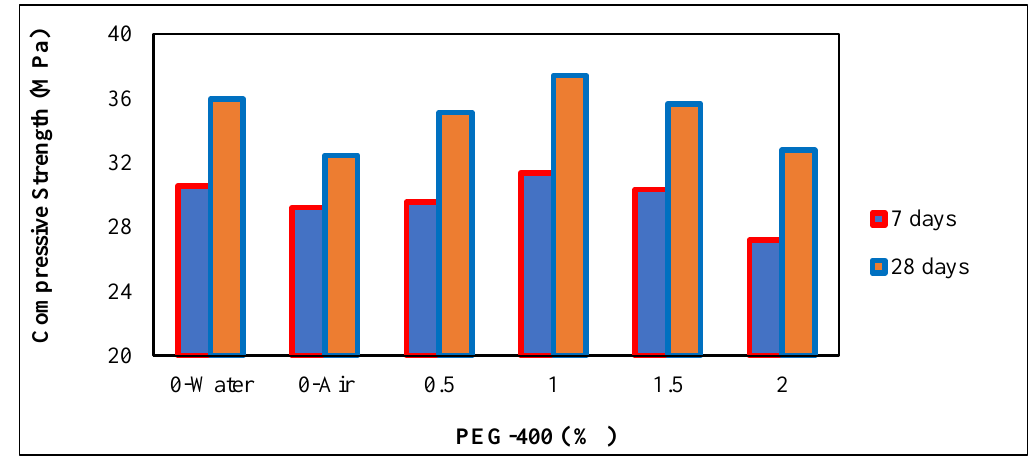
Figure 6. Compressive strength of concrete containing different percentages of PEG.